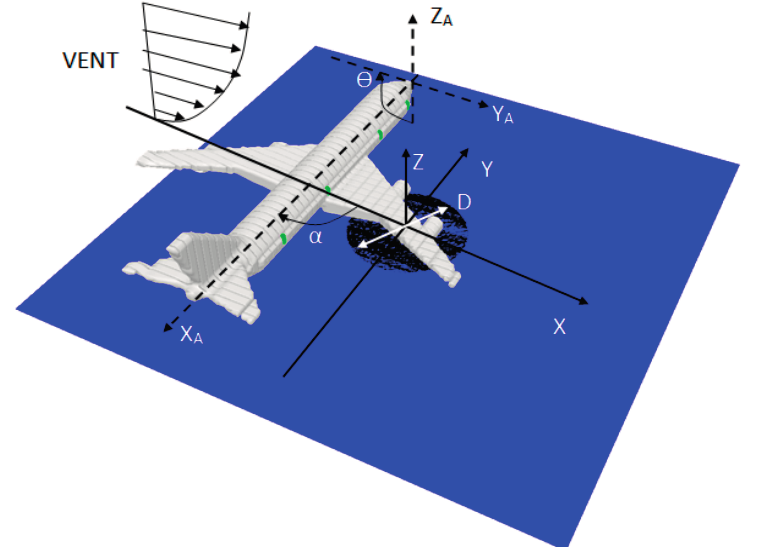
Figure 11. Schematic diagram of the occurrence of large fires engulfing an aircraft and the coordinate system in the numerical